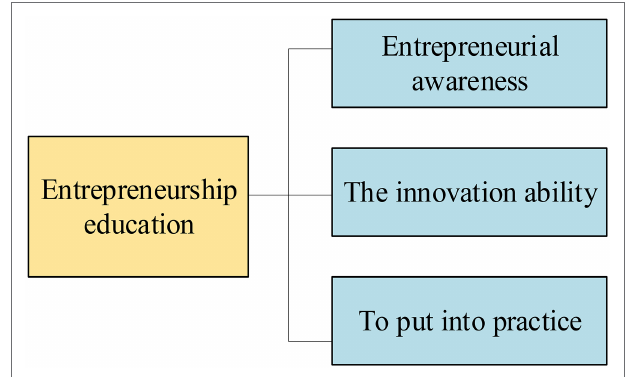
FIGURE 1 | Three stages of entrepreneurship